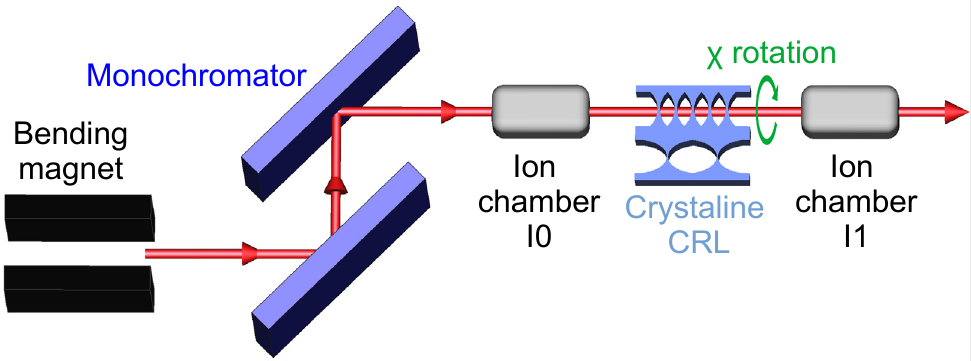
Figure 1. Glitch spectroscopy experiment at BM31 (SNBL), ESRF. The X-ray beam from the bending magnet is monochromatized and incident at a CRL. The intensity is measure before (I0) and after (I1) the sample with ion chambers.